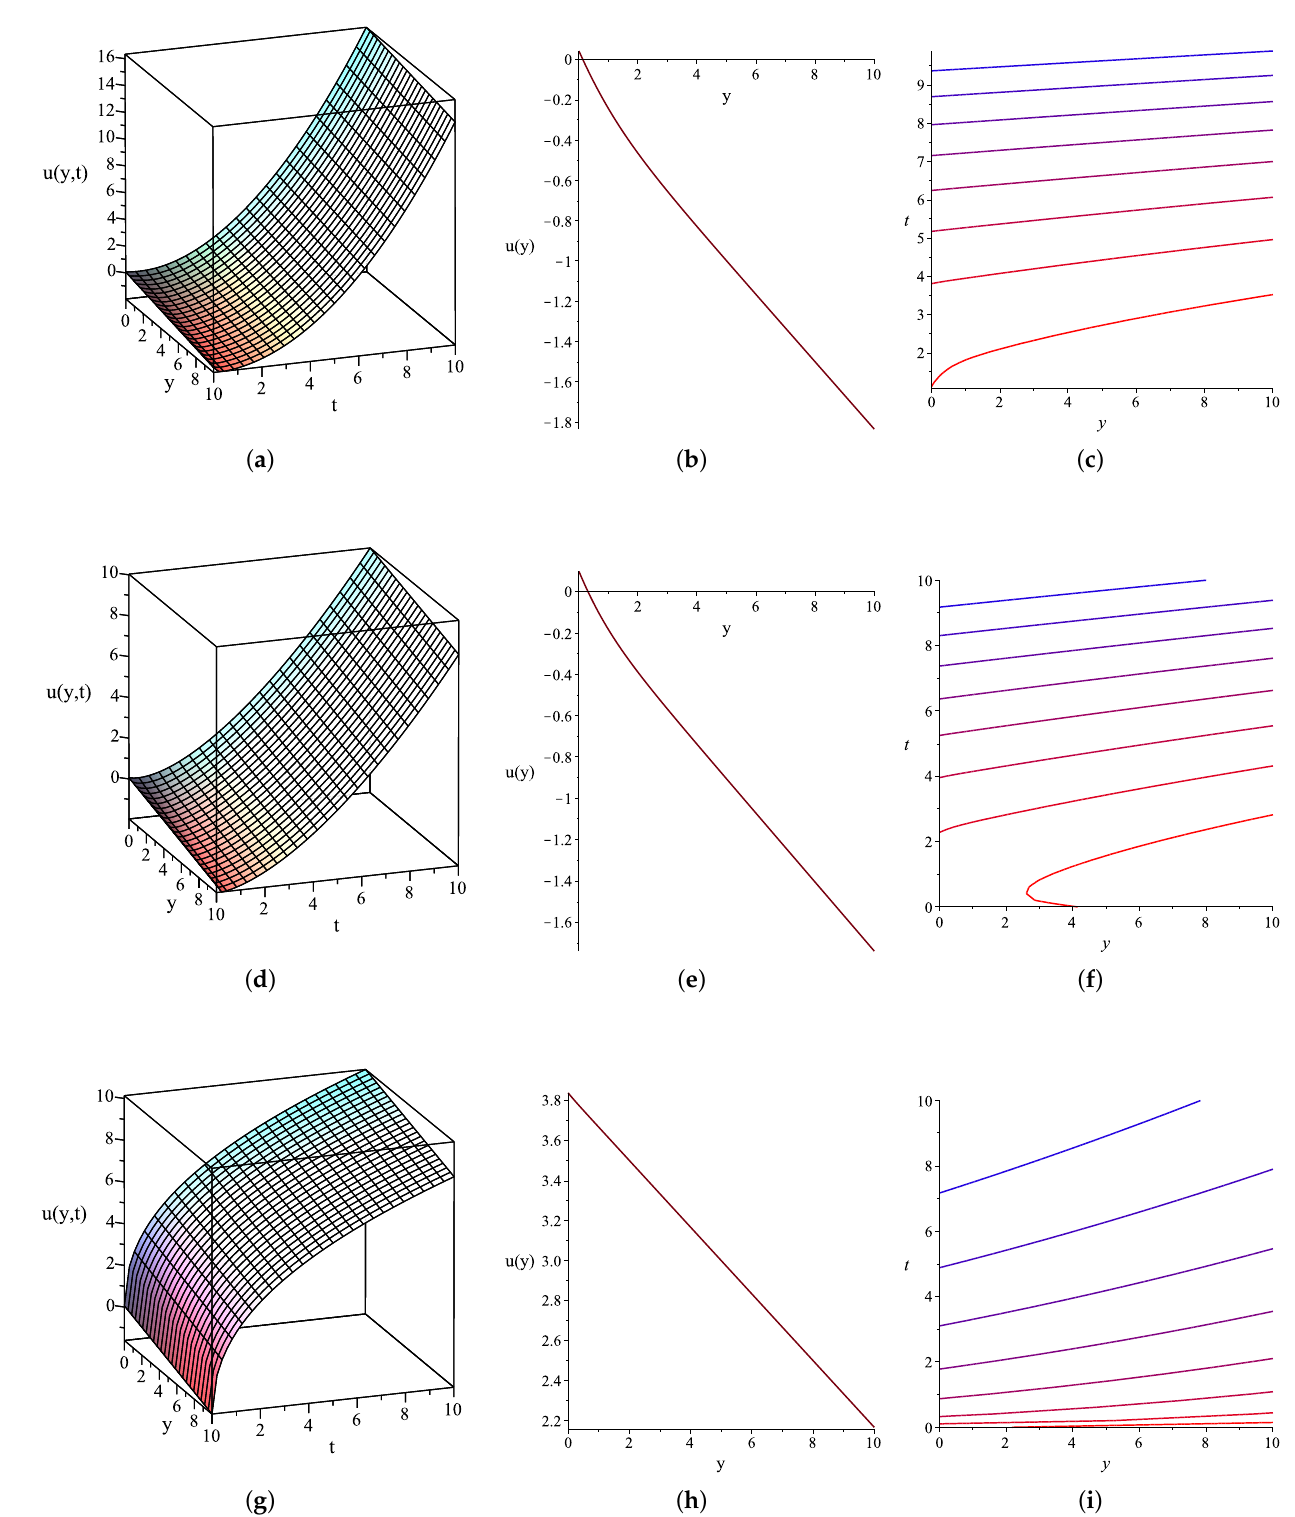
Figure 2. Associated plots of u 6 ( x , y , t ) in Equation (42) obtained using the auxiliary equation method: ( a – c ) 3-D plot, 2-D plot and contour plot, respectively when α = 1; ( d – f ) 3-D plot, 2-D plot and contour plot, respectively when α = 0.8; ( g – i ) 3-D plot, 2-D plot and contour plot, respectively when α =